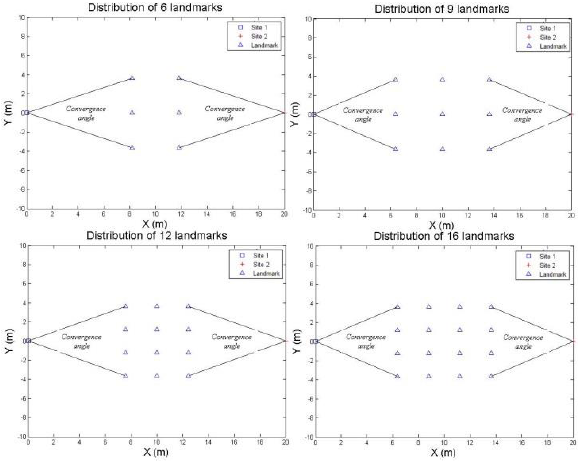
Figure 3. Landmarks distribution patterns.